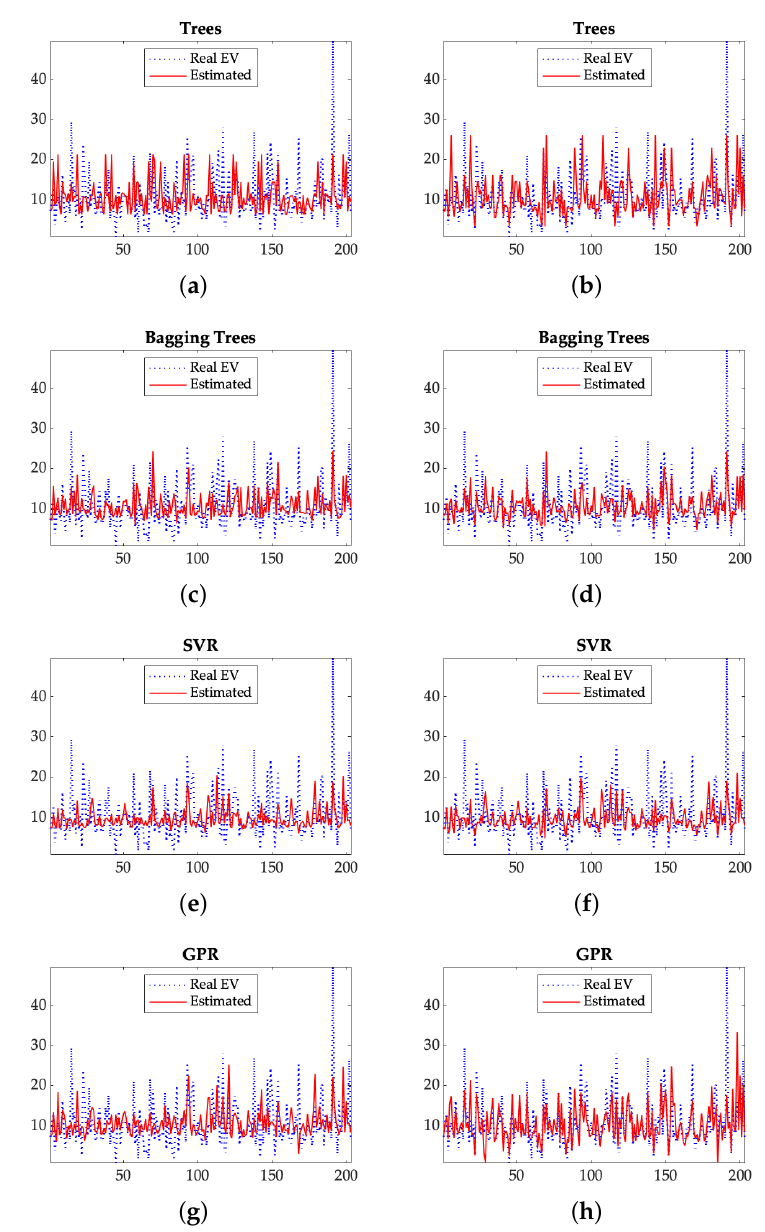
Figure 1. Representation of actual values for operational normalized EVs (in blue) and estimated EVs based on developed ML methods (in red), when using endogenous normalized variables (left panels) and both for endogenous normalized and exogenous variables (right panels). The benchmarked algorithms were decision trees ( a , b ), bagging trees( c , d ), SVR ( e , f ), and GPR ( g , h